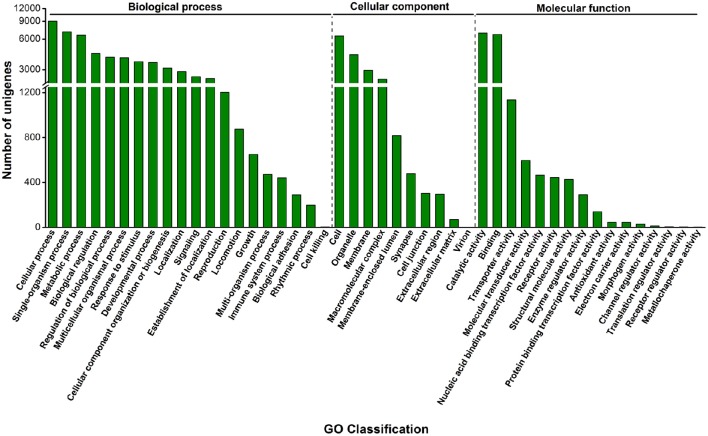
Distribution of green peach aphid sequences by GO category. GO classification includes three domains: biological process, cellular component, and molecular function. The y-axis shows the number of matching unigenes in a category.